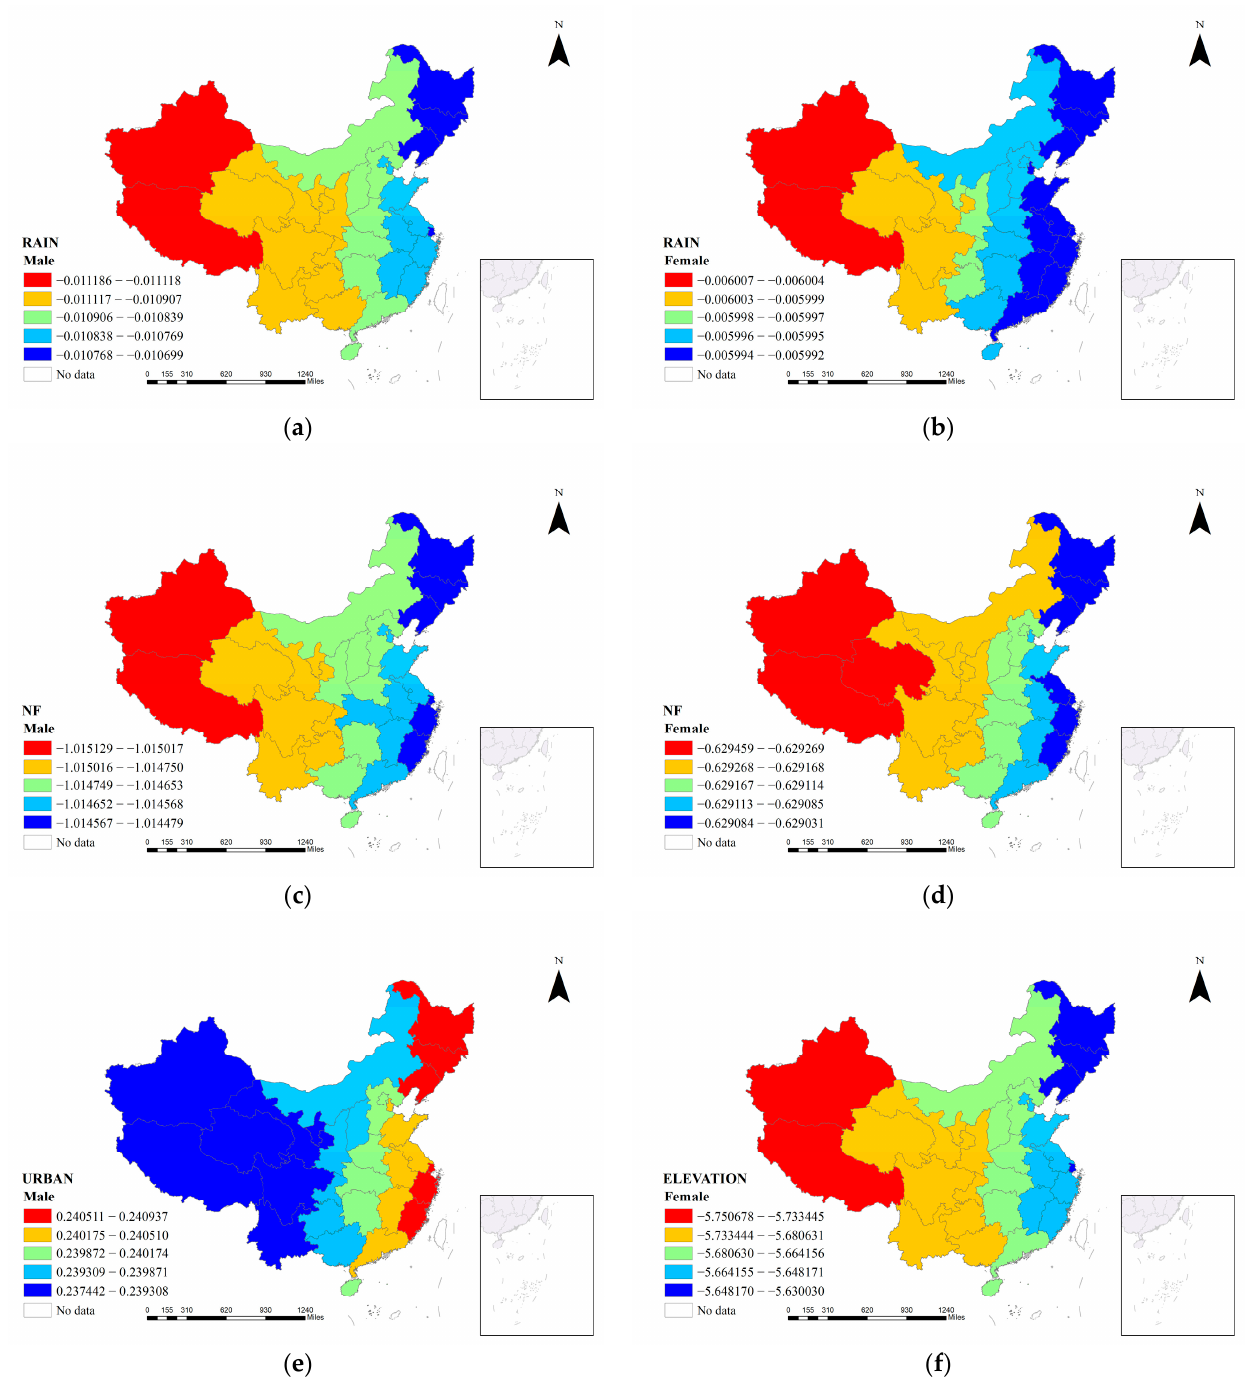
Figure 3. Spatial patterns of coefficients in the MGWR. ( a ) Annual precipitation in the male group; ( b ) annual precipitation in the female group; ( c ) non-farm output ratio in the male group; ( d ) non-farm output ratio in the female group; ( e ) urbanization rate in the male group; ( f ) elevation in the female group.